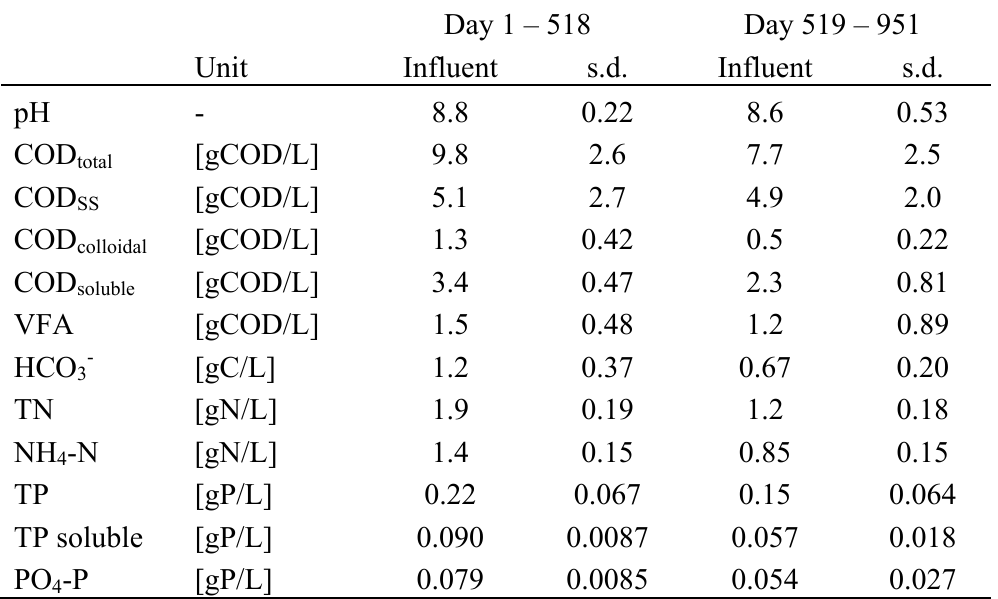
Table 3. Composition of the black water